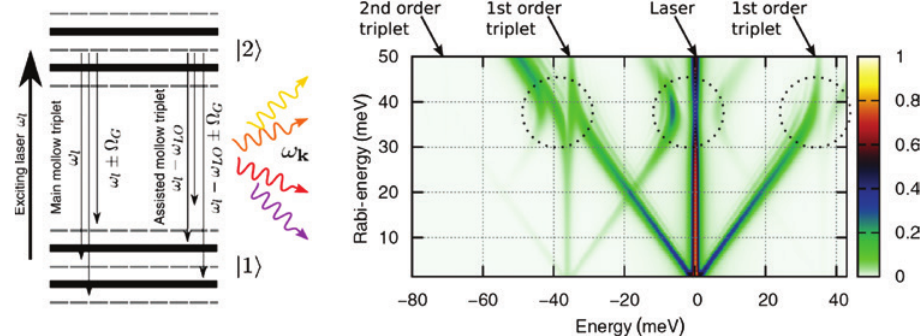
Figure 9: Scheme and power spectrum of a two-level system (e.g. QD) interacting coherently with strong external laser field. The emission consists of triplets centered at the driving laser frequency (Mollow triplet) and at the Raman frequencies (only Stokes contribution shown). For driving strength of the order of the LO phonon energy, additional anticrossings occur. © 2011 American Physical Society, reprinted from